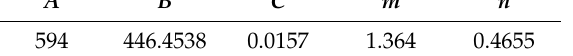
Table 2. The optimized material constants of JC model.